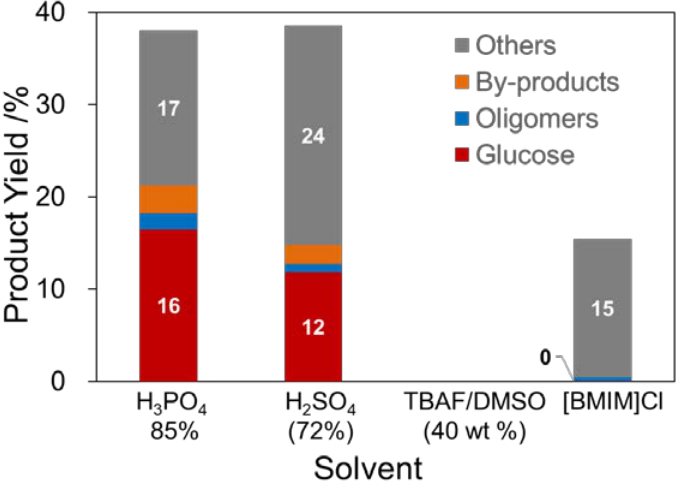
Figure 4. Yield of products after hydrolysis of cellulose treated with different solvents and precipitated in the presence of AC–Air catalyst. Cellulose treatment condition: 0.324 g cellulose, 16.2 g solvent, 15 min stirring, 0.324 g AC–Air, precipitation with 30 mL H 2 O followed by washing with 300 mL H 2 O. Hydrolysis reaction conditions: wet cellulose + AC-Air mixture obtained after pretreatment, 40 mL water, 180 ◦ C, 20 min. By-products include fructose, 5-HMF and levoglucosan. “Others” is the difference between cellulose conversion and identifiable products.